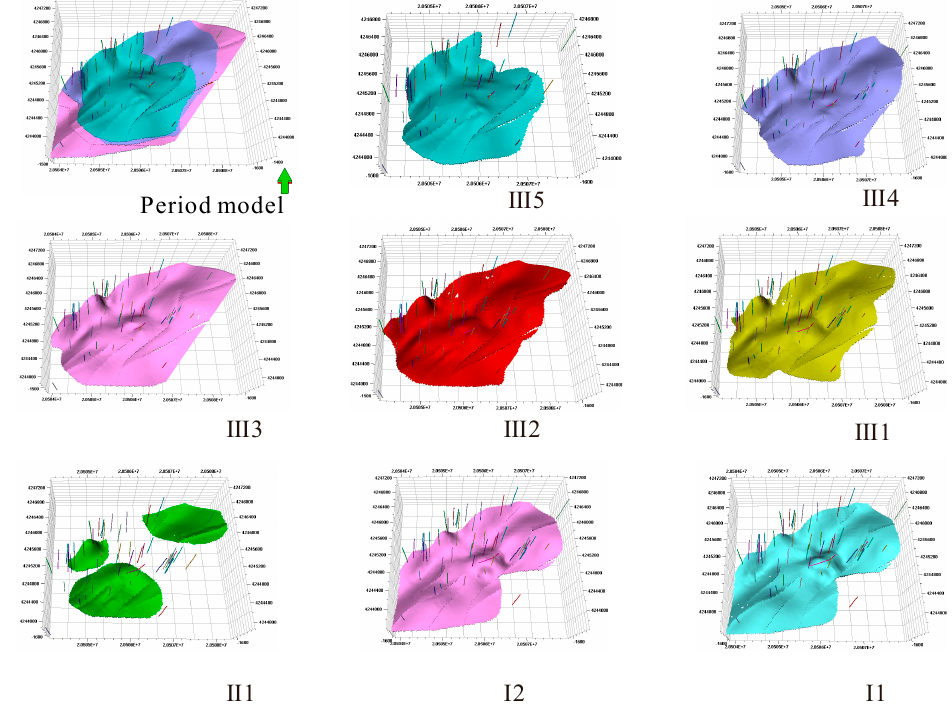
Energies 2022 , 15 , x FOR PEER REVIEW Figure 10. Wells section of volcanic stages division in the Zao35 block. Figure 10. Wells section of volcanic stages division in the Zao35 block.